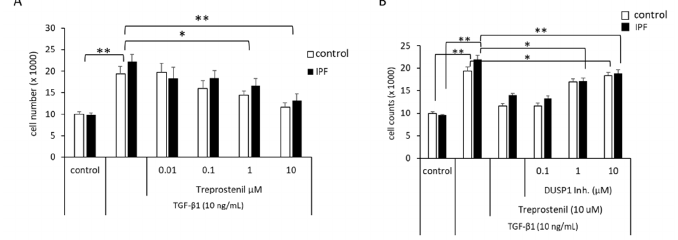
Figure 6. Proliferation control by treprostinil and DUSP1. ( A ) Cell counts were performed 48 h after stimulation with TGF- β 1 (10 ng/mL) in the absence or presence of treprostinil at increasing concen- trations. ( B ) Cells were pre-incubated (30 min) with increasing concentrations of the DUSP1 inhibi- tor BCI-CAS 15982-84-0 (DUSP1 Inh.) before being treated with treprostinil (10 μ M, 30 min), fol- lowed by stimulation with TGF- β 1 (10 ng/mL). Bars represent mean ± SEM of five control lines or eight IPF cell lines, respectively. p -values were calculated by ANOVA and Student’s t -test. * indi- cates p < 0.05, ** indicates p < 0.01.